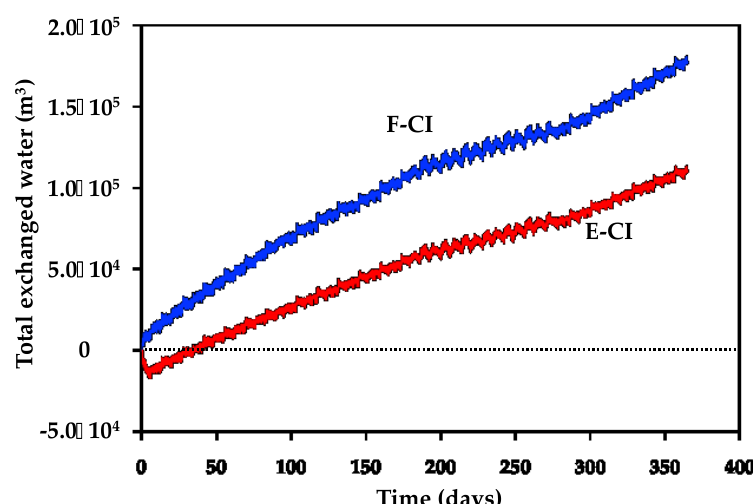
Figure 10. Total volume of exchanged water (m 3 ) for the F-CI (blue) and E-CI (red) scenarios. Total volume of exchanged water refers to the difference between water that enters into the underground reservoir and water that flows towards the surrounding medium. Positive values mean that, globally, more water is entering into the underground reservoir while negative values occur when outflow is higher than inflow.